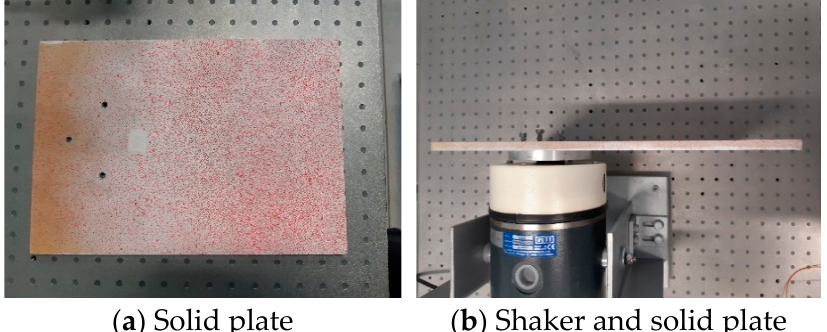
Figure 2. Rigid solid and shaker system.